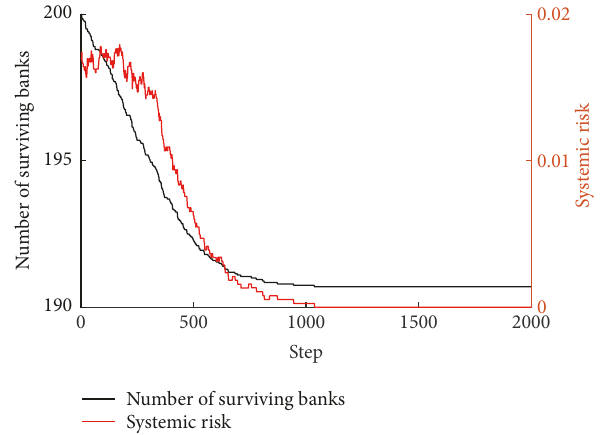
Figure 3: Changes in the number of surviving banks in the bank network as well as the corresponding systemic risks. The parameters are set as 𝑑 = 0.1067 , 𝜃 = 0.02 , 𝛿 𝑎 V 𝑒 = 0.009 , 𝑝 = 0.05 , 𝐶 = 0.03 , 𝜎 = 0.15 , 𝜎 = 0.25 , 𝐴 = 1000 , 𝑤 = 500 , 𝜒 = 0.3 , 𝛽 = 0.25 , 𝐴 𝑤 𝑁 = 200 , 𝑀 = 150 , 𝑟 = 0.004 , and 𝑟 = 0.008 𝑎 𝑏